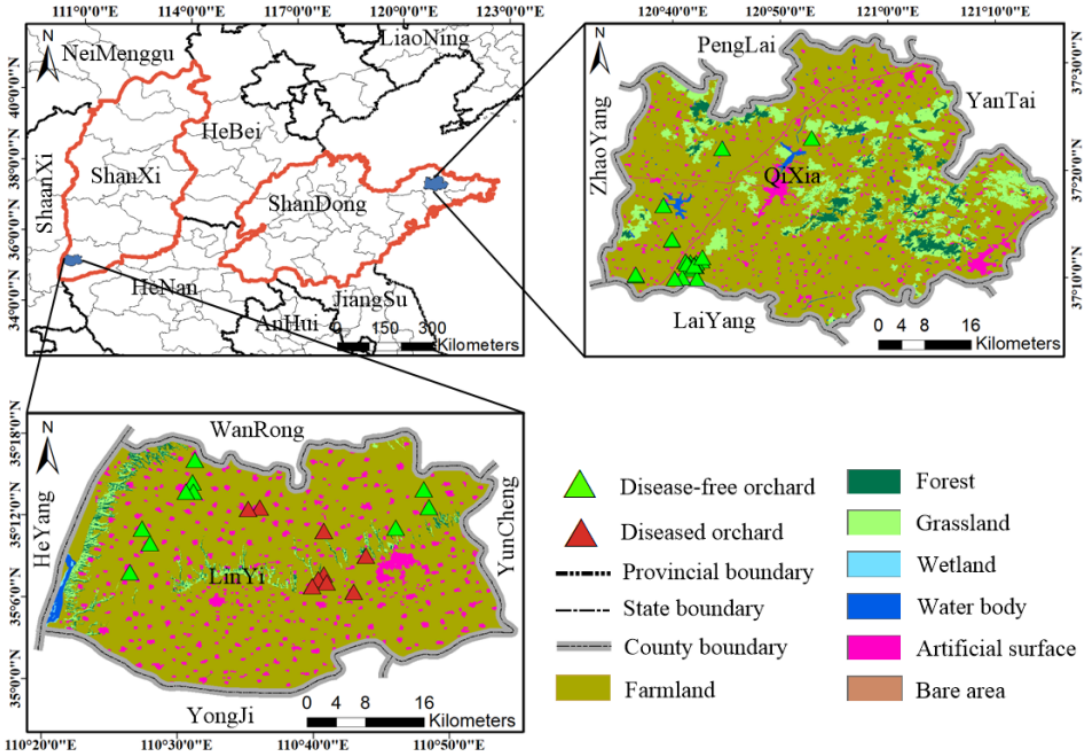
Figure 1. A landcover map of the study areas.